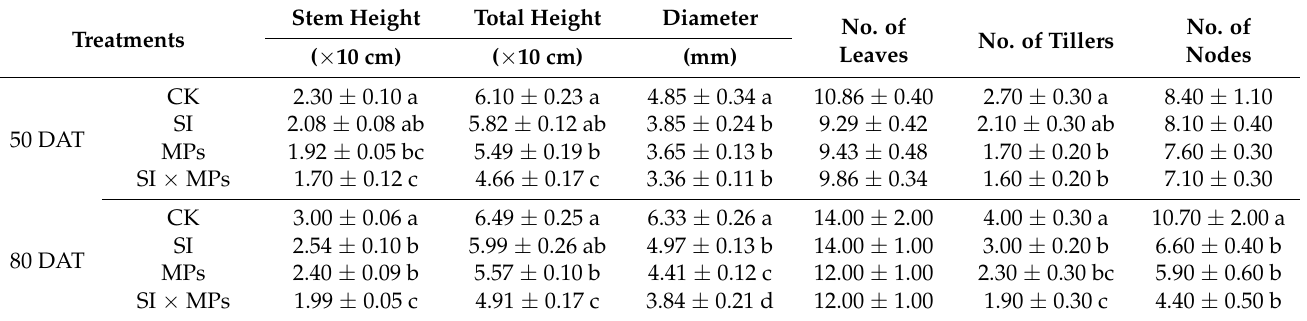
Table 2. Mean rice phenotypic indices at 50th and 80th days after transplanting, presented as mean ± standard error ( n = 7).